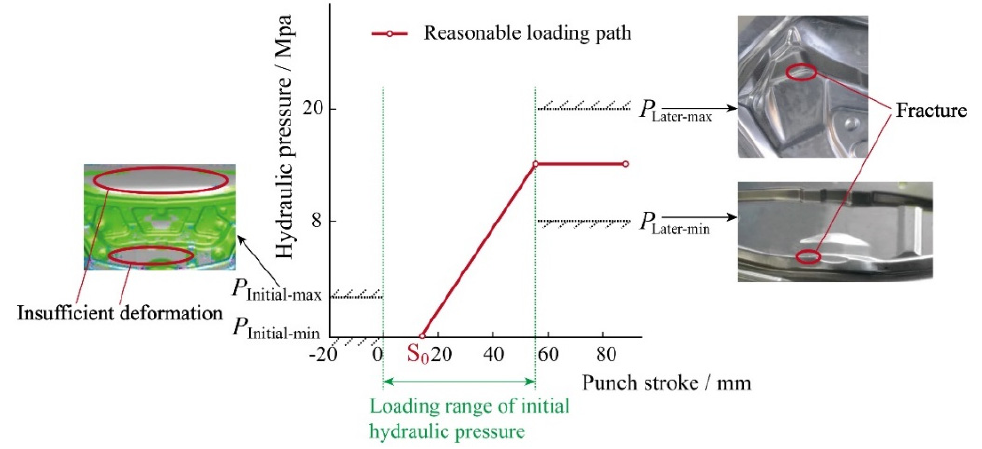
Figure 4. Range of hydraulic pressure loading path.